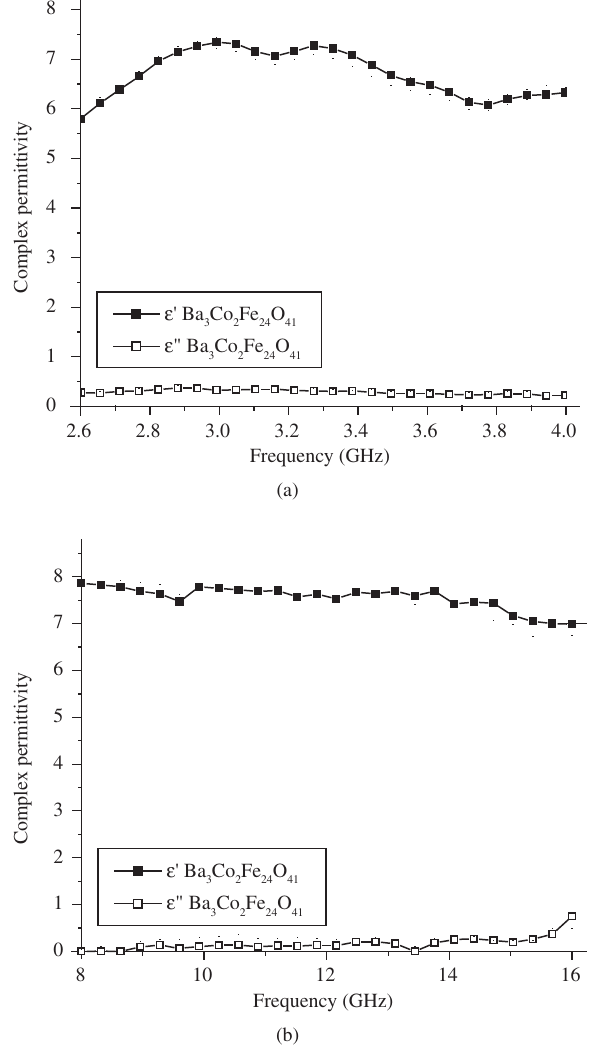
Figure 6. Complex pemeability (µ * ) as a function of frequency (GHz) for Ba Co Fe O /CR composites (80/20, wt. (%)), ( ■ real) and x ( □ imaginary): 3 2 24 41 a) S-band and b) X-kU bands.